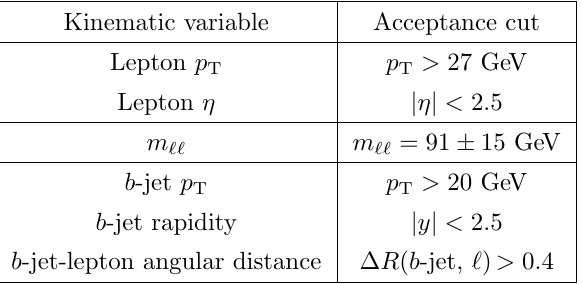
Table 7 . Kinematic criteria de(cid:12)ning the (cid:12)ducial phase space of the measurement at particle level. R = 0 : 4 to all (cid:12)nal-state particles with a lifetime longer than 30 ps, excluding the dressed Z -boson decay products. A jet is identi(cid:12)ed as b -tagged if it lies within (cid:1) R = 0 : 3 of one or more weakly decaying b -hadrons with p > 5 GeV. If a b -hadron matches more than one T jet, only the closest jet in (cid:1) R is labelled as a b